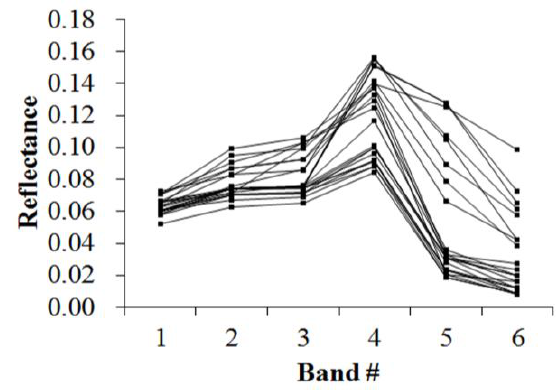
Figure 11. Spectral curves collected from samples used to determine Table 9.